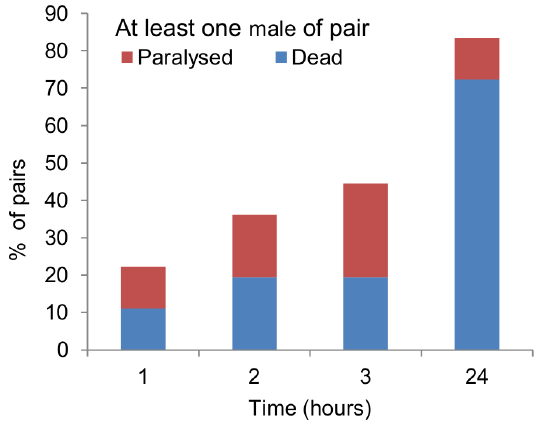
Figure 3. Time course of killing in IJ-derived males. Percentage of pairs of male Steinernema longicaudum in which one male was either paralysed or dead at various times after the males were placed together; N=36 pairs. None of the 36 single male controls was paralysed or dead after 24 h.